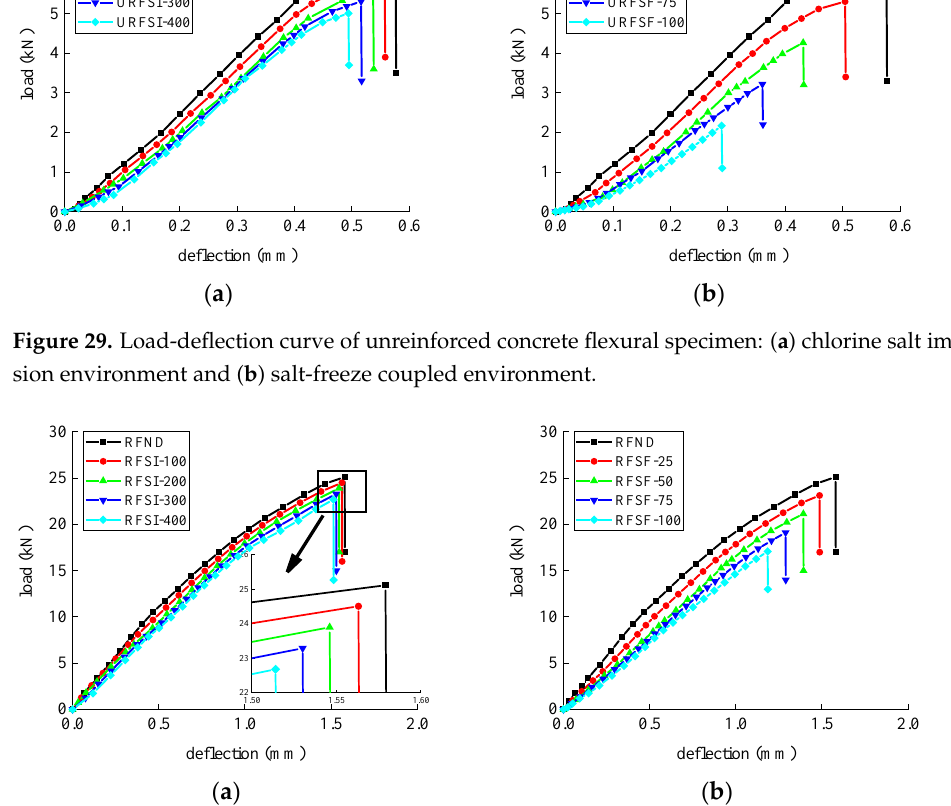
Figure 30. Load-deflection curve of reinforced concrete flexural specimen: ( a ) chlorine salt immersion environment and ( b ) salt-freeze coupled environment.